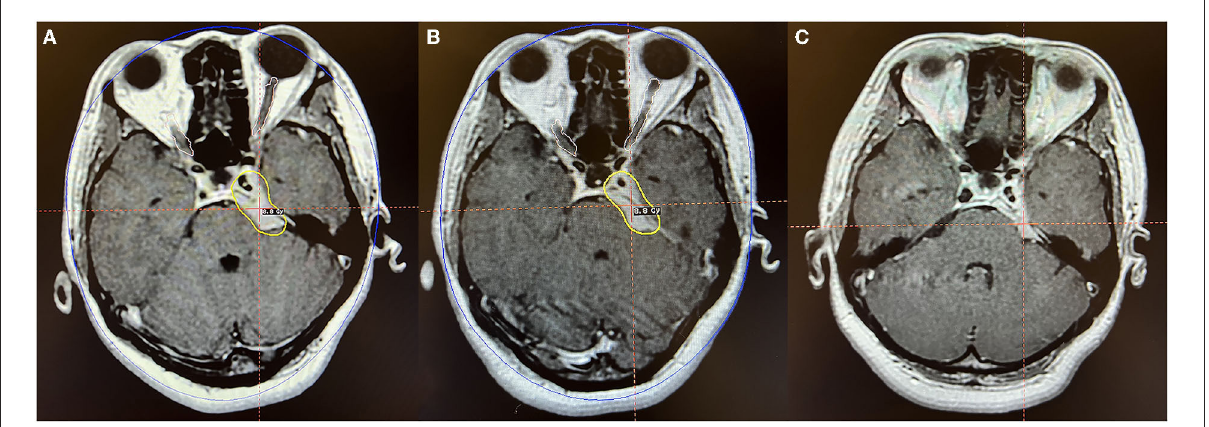
FIGURE4 Axial MR imaging illustrating a petroclival middle-posterior communicating meningioma treated with Gamma Knife radiosurgery. (A) The prescription dose planning MRI for the first stage of Gamma Knife radiosurgery displaying that the tumor margin was covered by 8.8Gy (45% isodose surface), and the tumor volume was 7.0 cc. (B) In the second fraction, the tumor was treated with the same dose as the first stage, and the tumor volume was 6.1 cc. (C) MRI obtained 24 months after radiosurgery indicated that the tumor volume is 4.7 cc, decreased by 33.0% compared with the pre-radiosurgery volume. No obvious adverse reactions were observed.